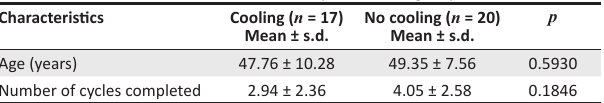
TABLE 3: Further baseline characteristics by treatment group. Characteristics Cooling ( n = 17) Mean ± s.d.